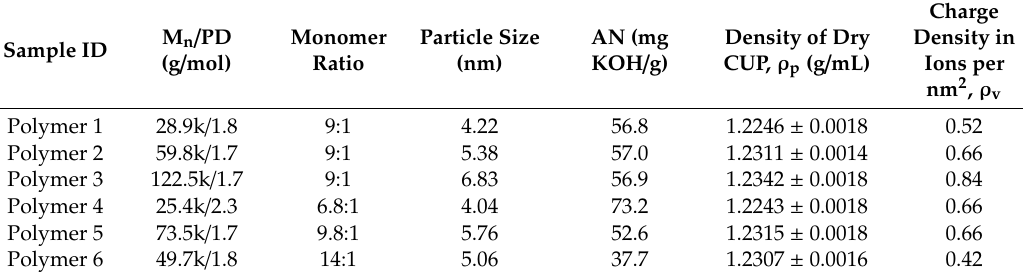
Table 1. Molecular weight, particle size, acid number and density of the polymers